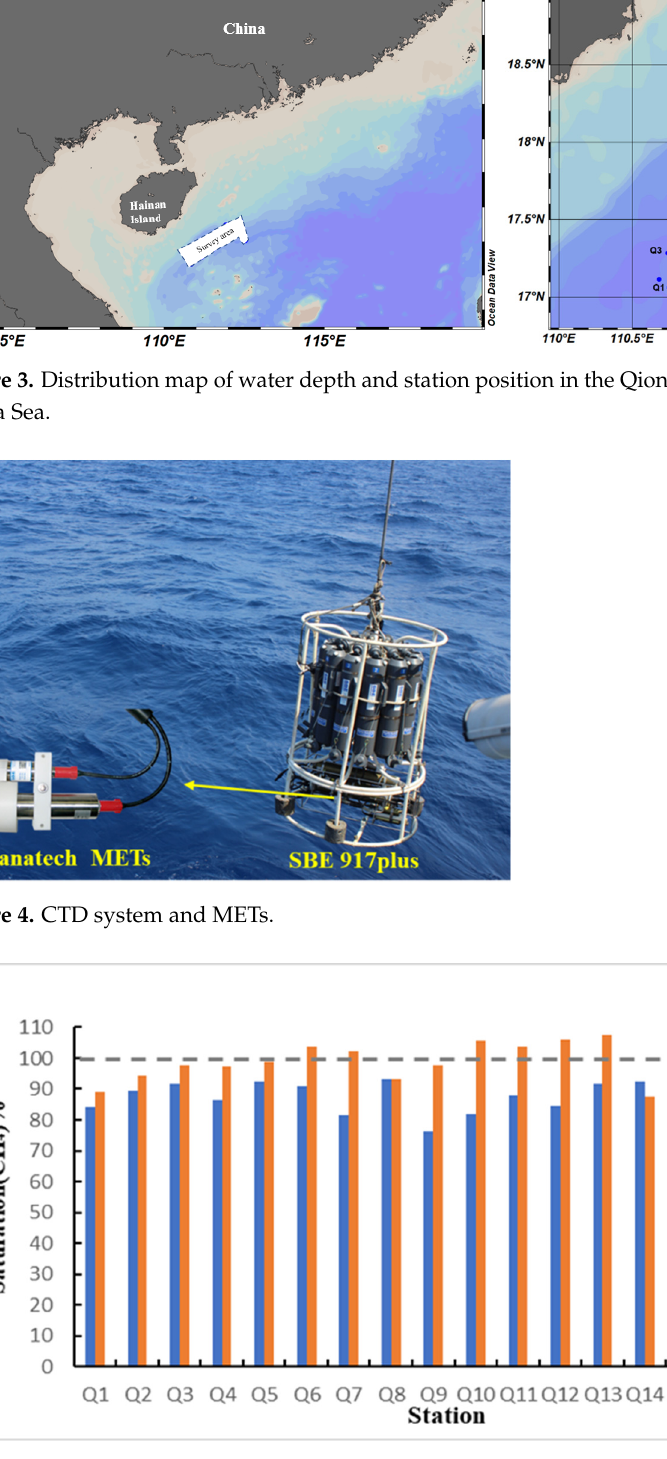
Figure 5. The saturation of methane in the surface water of each station in different seasons in the Qiongdongnan area.